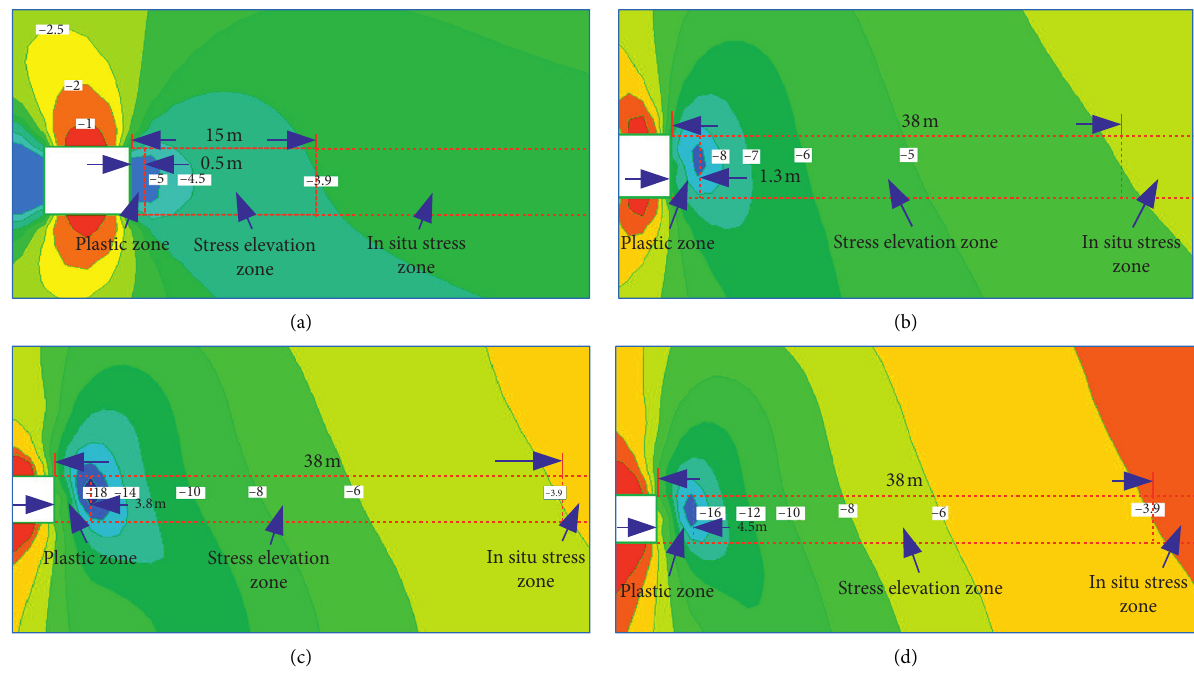
Figure 10: Vertical stress distribution of lateral coal. (a) − 30m stress distribution nephogram (note: − 30m is 30m in front of the initial measuring point). (b) Nephogram of stress distribution at open cut. (c) 40m stress distribution nephogram (note: 40m is 40m behind the initial measuring point). (d) Stress distribution nephogram of 80 m (note: 80m is 80m behind the initial measuring point).